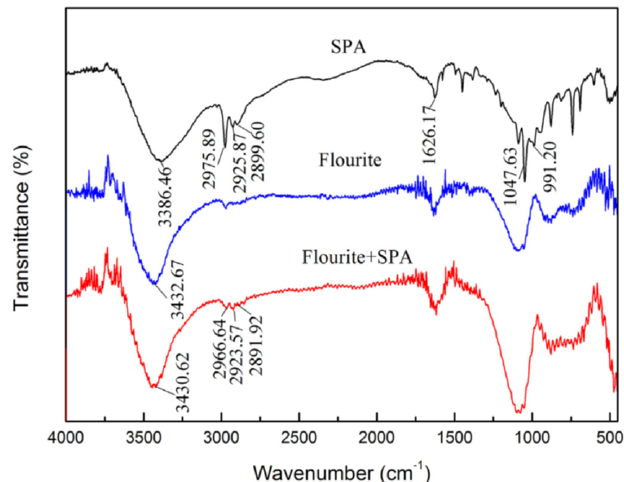
Figure 4. FT-IR spectrum of SPA, fluorite and fluorite treated with SPA [74].